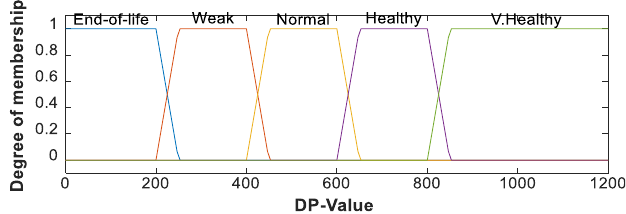
Figure 3. Membership functions for output DP value.